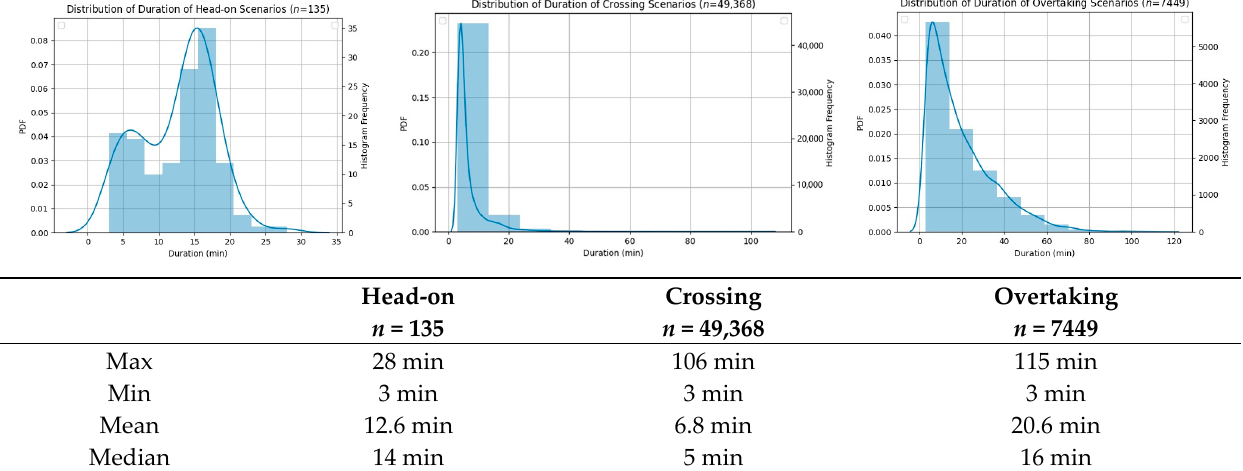
1.0 nm Figure 9. Distribution of safety passing distance of different encounter scenarios. The numbers in- dicate the minimum relative distance between OS and TS during encounter scenarios. The probability distributions of these scenario parameters can be not only used to generate a huge number of test scenarios that conform to the characteristics of real marine traffic, but are also useful to analyze and evaluate the autonomous collision avoidance algorithm, such as using the safety passing distance to assess the safety of collision avoid- ance algorithms.